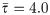
Interspike-time and frequency-count histograms of a simulation of diffusive vesicles under an attractive harmonic potential, before and after time-rescaling.(A), (C) Interspike-times histograms f(δt) and f(δτ) before and after time rescaling, respectively. (B),(D) frequency-count histograms P(k) (for a time interval of T = 2.3 s width) and P(κ) (for a rescaled time interval of τ¯=4.0 width) before and after time rescaling, respectively. The histograms f(δt) and f(δτ) are fitted with gamma-(solid lines) and exponential distributions (dashed lines). The frequency-count histograms P(k) and P(κ) are fitted with the gamma-count (see text, solid lines) and Poisson distributions (dashed lines). The number of spikes was 4237. Inset plots in (A) and (C) show the spike rates of the original and time rescaled spike series, respectively.